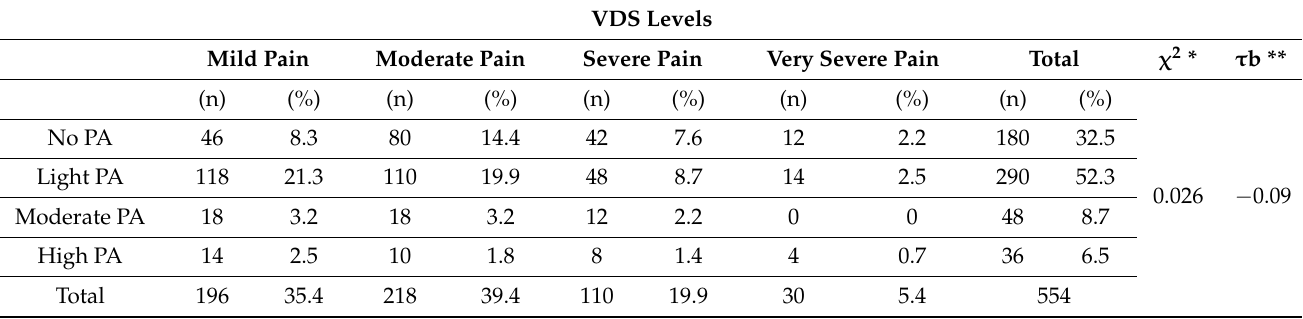
Table 8. Contingency table of physical activity levels and VDS low back scores.